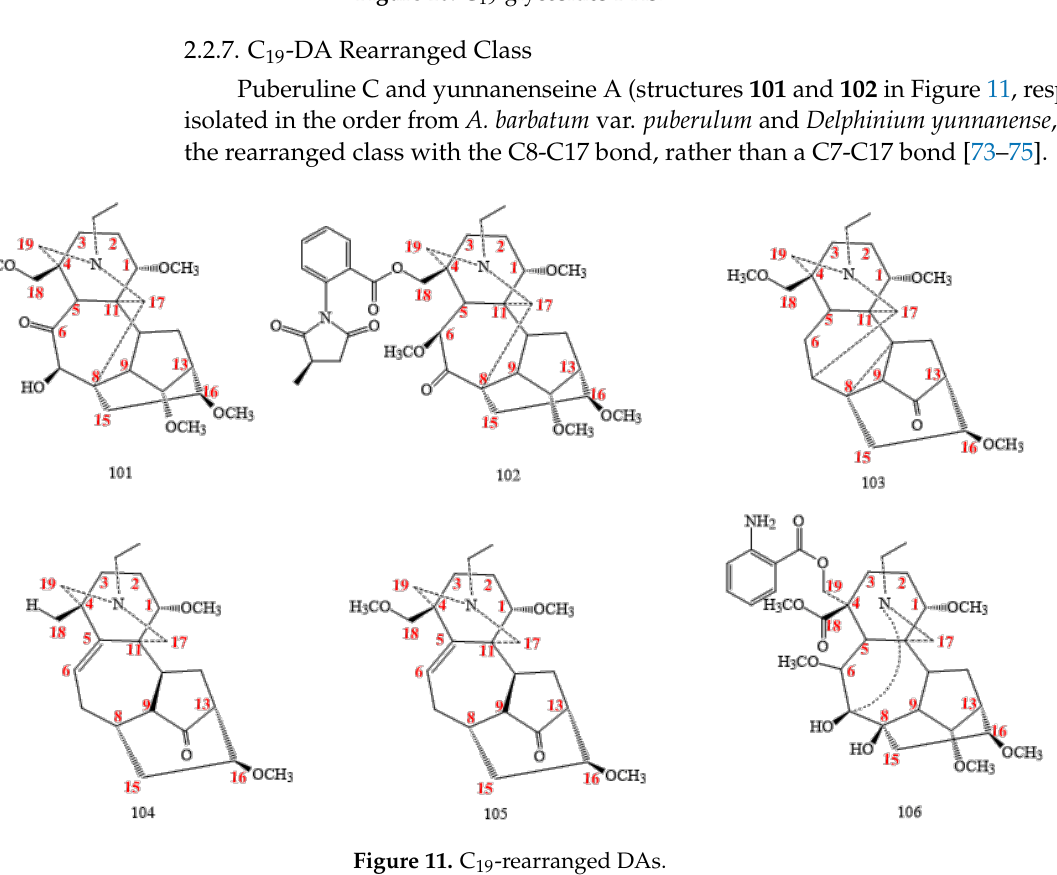
Figure 11. C 19 -rearranged DAs.